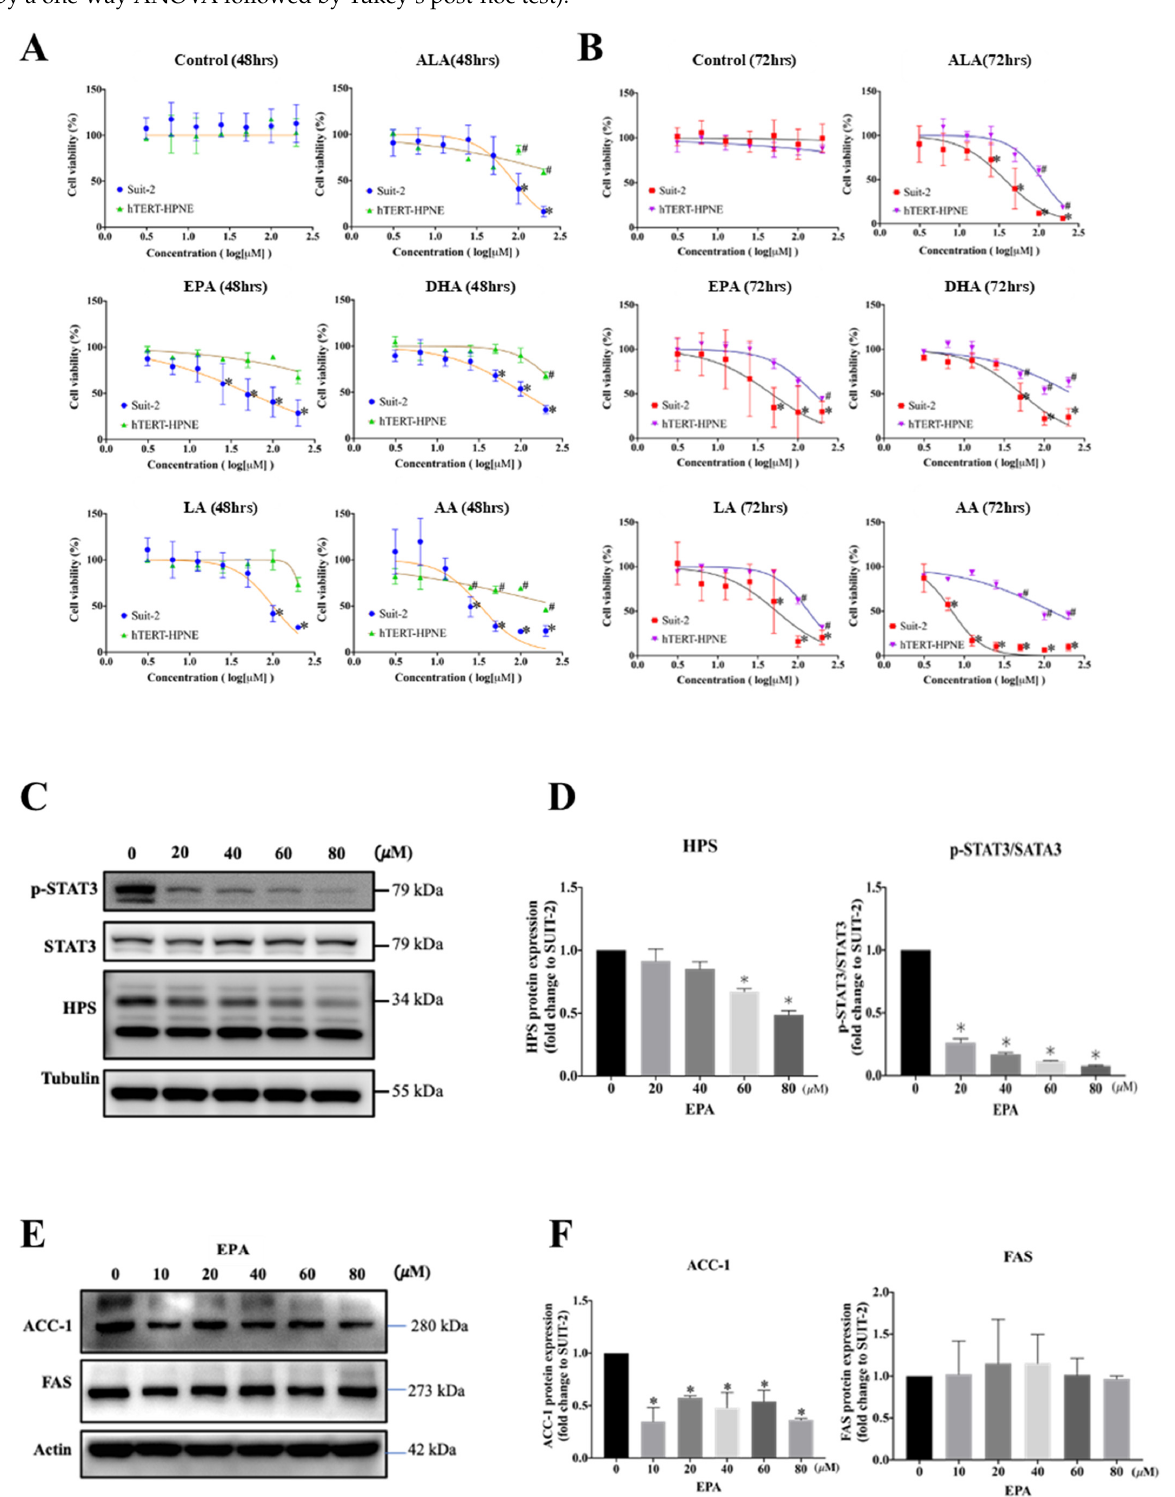
Figure 5. Treatment with n-3 and n-6 polyunsaturated fatty acids (PUFAs) decreases the viability of SUIT-2 cells. SUIT-2 and hTERT-HPNE cells were exposed to different concentrations (0, 3.125, 6.25, 12.5, 25, 50, 100, and 200 µ M) of n-3 or